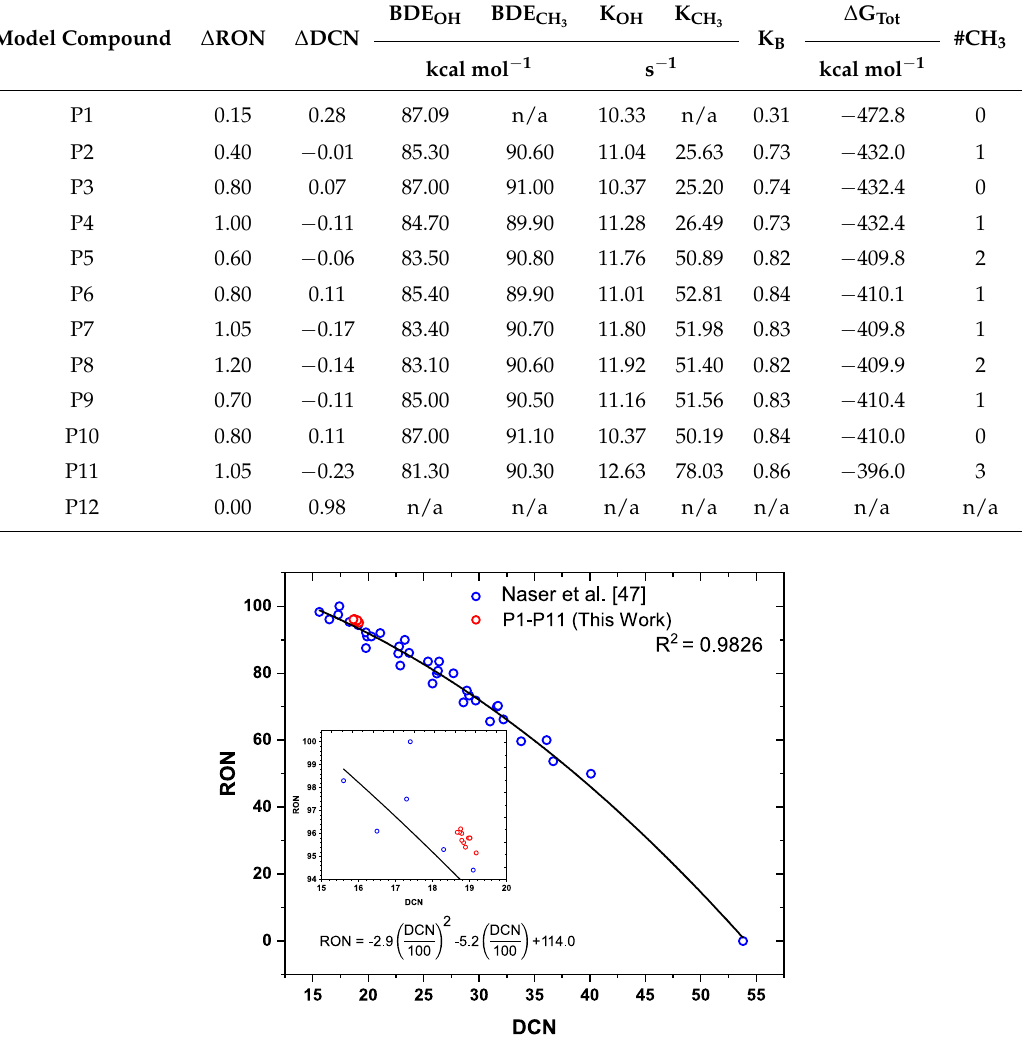
Table 1. Experimental and fundamental molecular thermodynamic anti-knock parameters of the model compounds, where K is the reaction rate and K B the branching fraction.